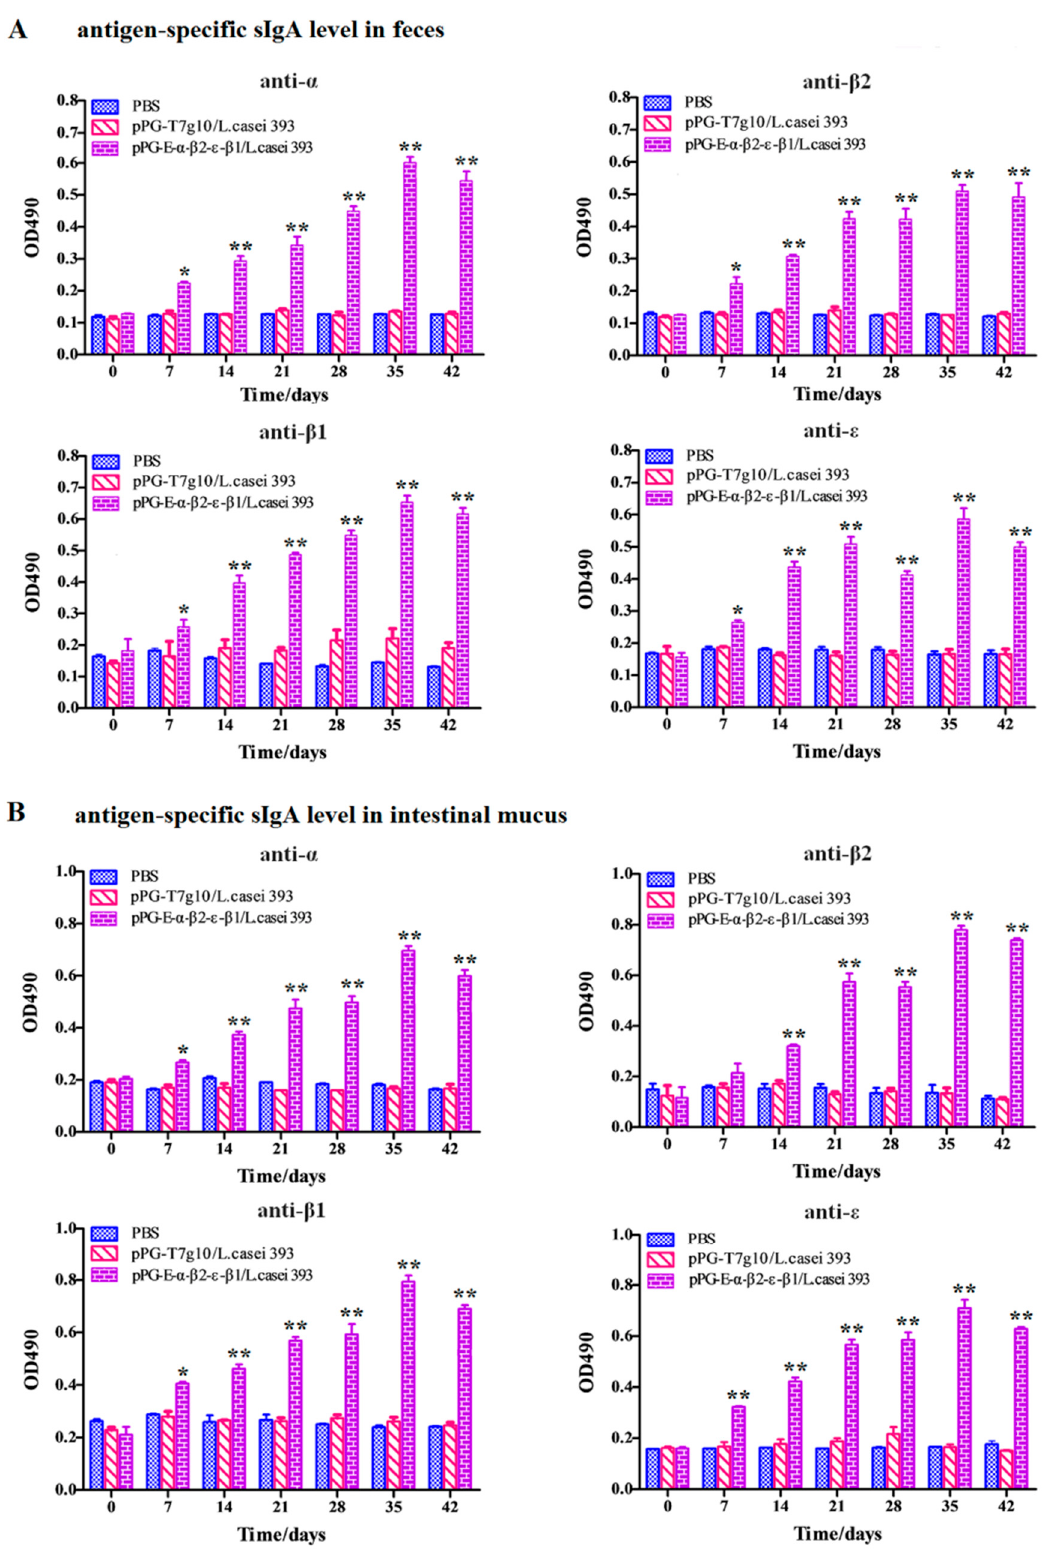
Figure 4. The levels of antigen-specific sIgA antibody in the feces ( A ) and in the intestinal mucus ( B ) of rabbits were determined using ELISA at different time points after the primary immunization with the bait particle vaccine. The results are presented as mean ± SD of each group (* p < 0.05, ** p < 0.01).